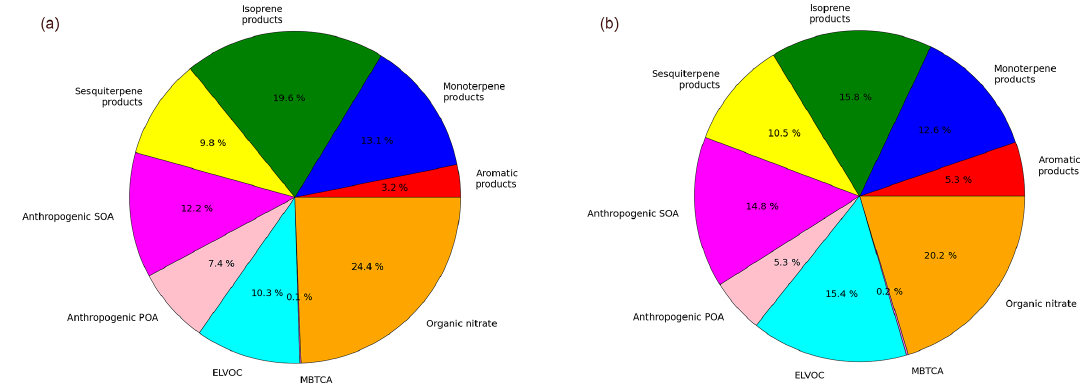
Figure 4. Simulated composition of OM 1 during the summer campaigns of 2012 (a) and 2013 (b) .